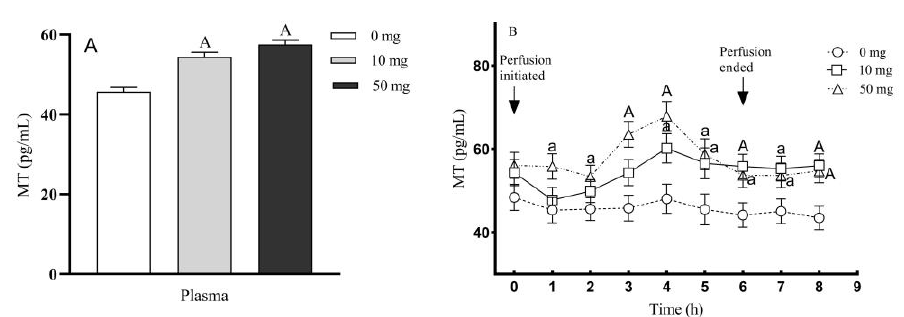
Figure 7. Effects of different doses of 5-HTP duodenal perfusion on circulating blood MT concentrations. ( A ) Circulating blood melatonin concentration. ( B ) The timely dynamic changes of circulating blood MT concentration after 5-HTP duodenal perfusion. The data were expressed as LSM ± SEM ( n = 6). Small